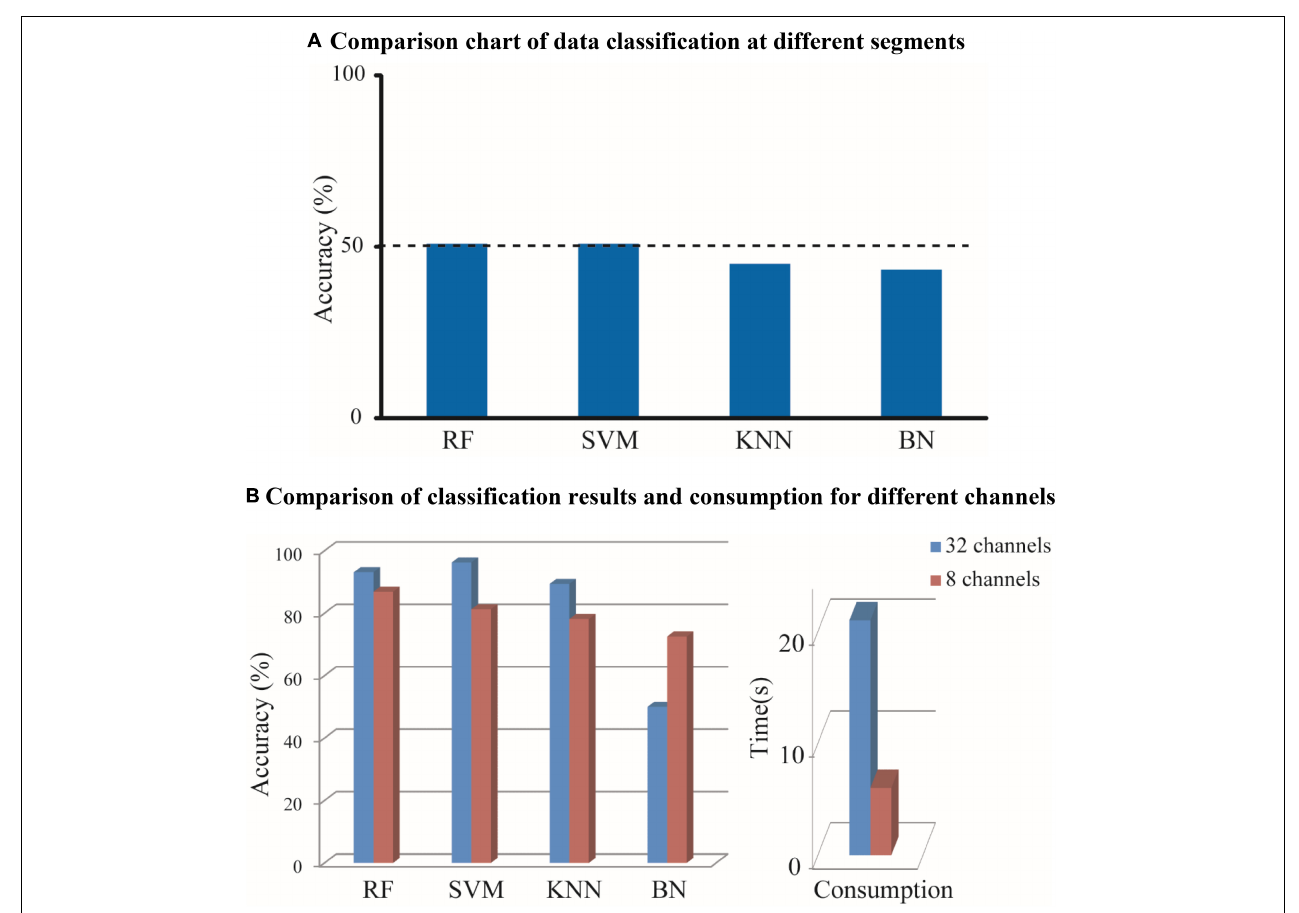
FIGURE 2 | According to different consumption and a different number of channels, the EEG signals are recognized by a variety of classifiers. The classification accuracy was obtained and the consumption was calculated. (A) Comparison chart of data classification at different segments. (B) Comparison of classification results and consumption for different